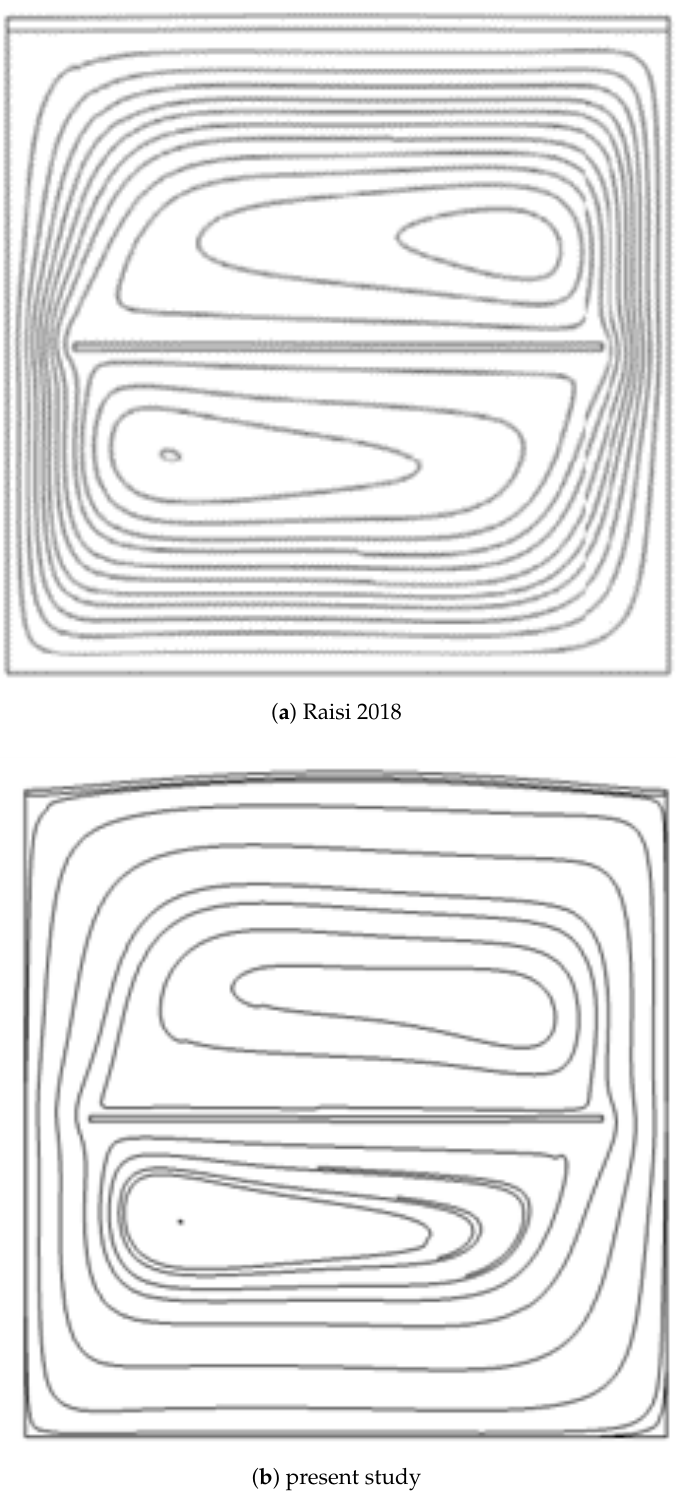
Figure 4. Streamline comparisons by using the reference study in Ref. [65], where convection in a flexible walled enclosure with an elastic baffle was analyzed (Ra = 10 5 , E* = 8 × 10 9 , ρ s* = 6000 and baffle length of